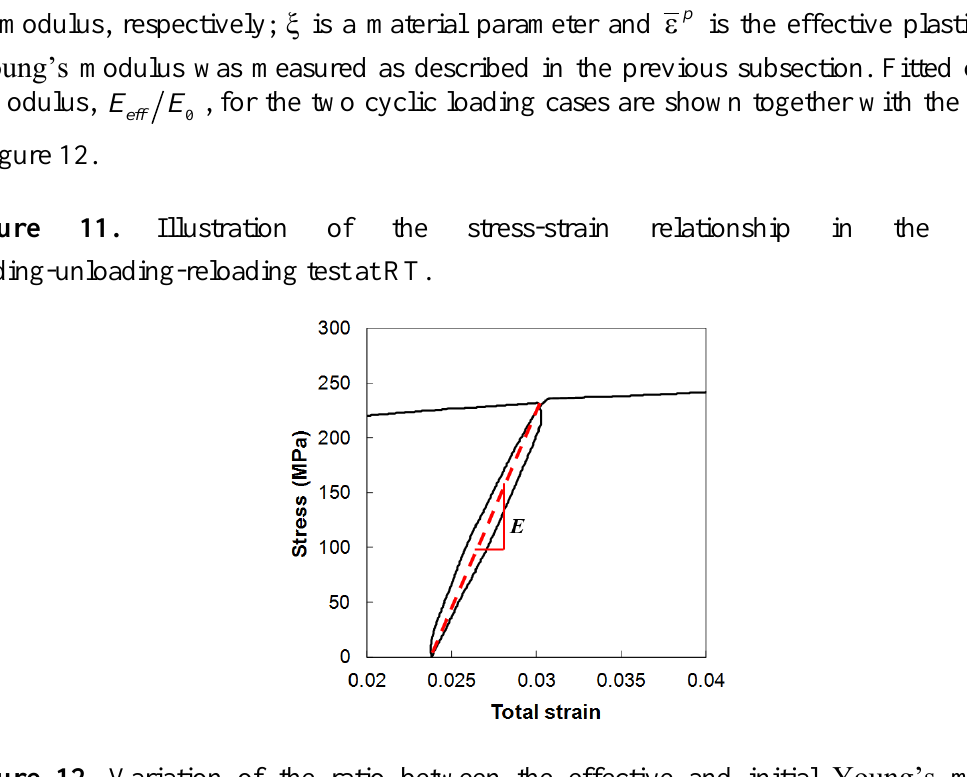
Figure 12. Variation of the ratio between the effective and initial Young’s modulus with plastic strain at RT for: ( a ) tension and ( b ) compression cyclic